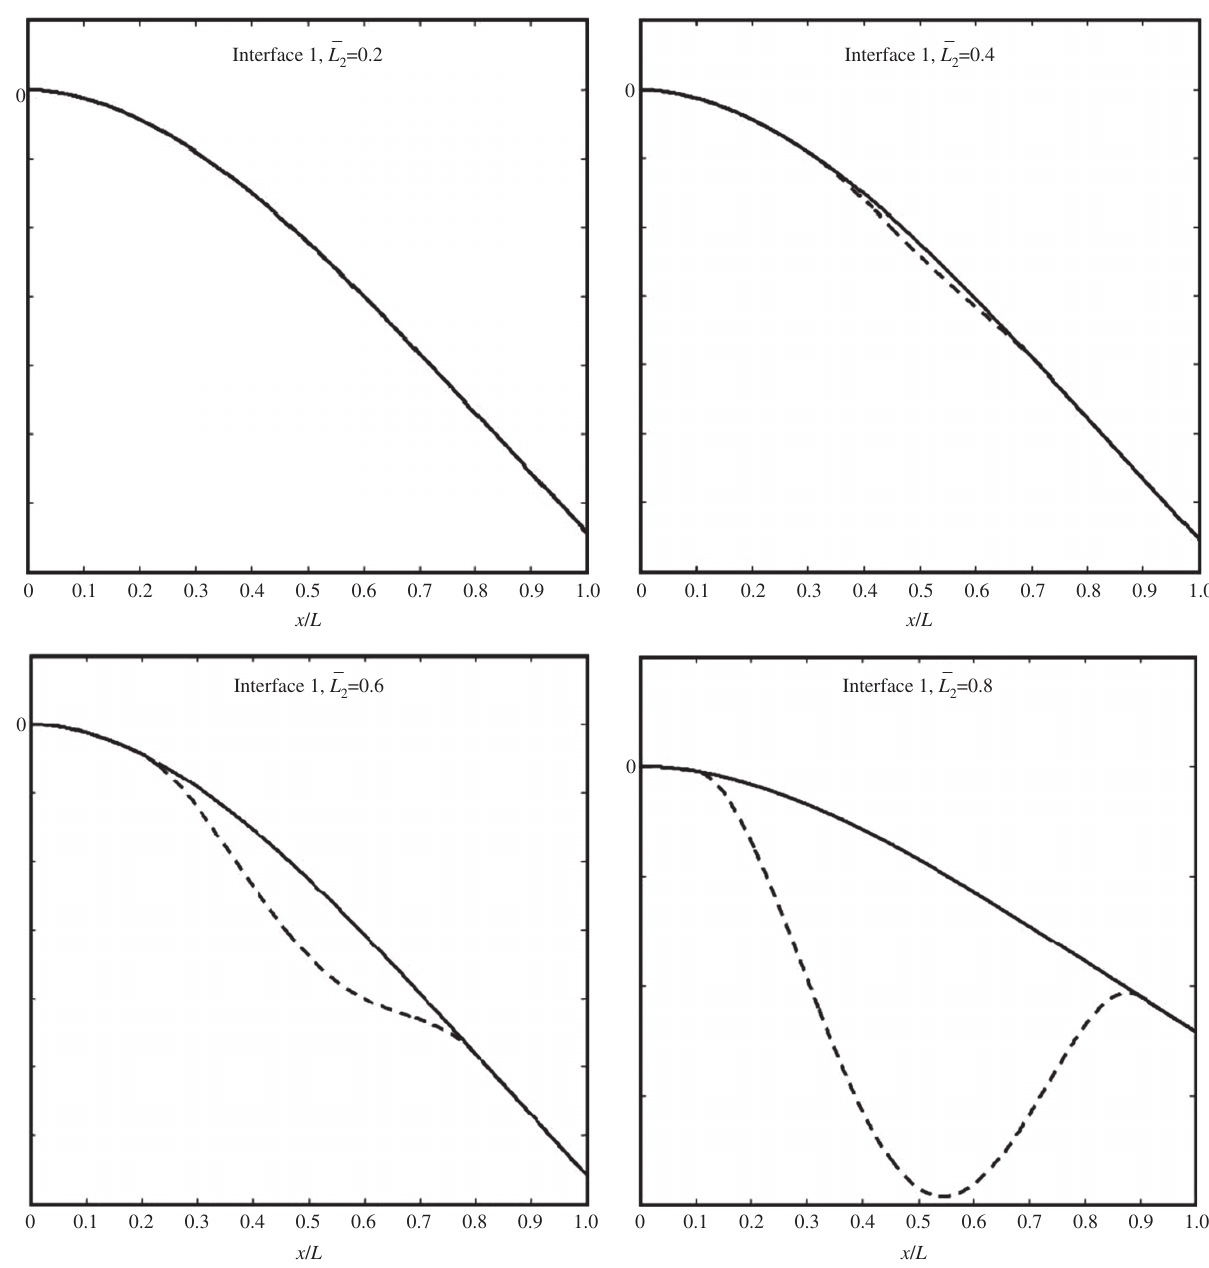
Figure 11 First mode shape of a LCB with delamination located at interface 1 related to four different lengths of delamination.